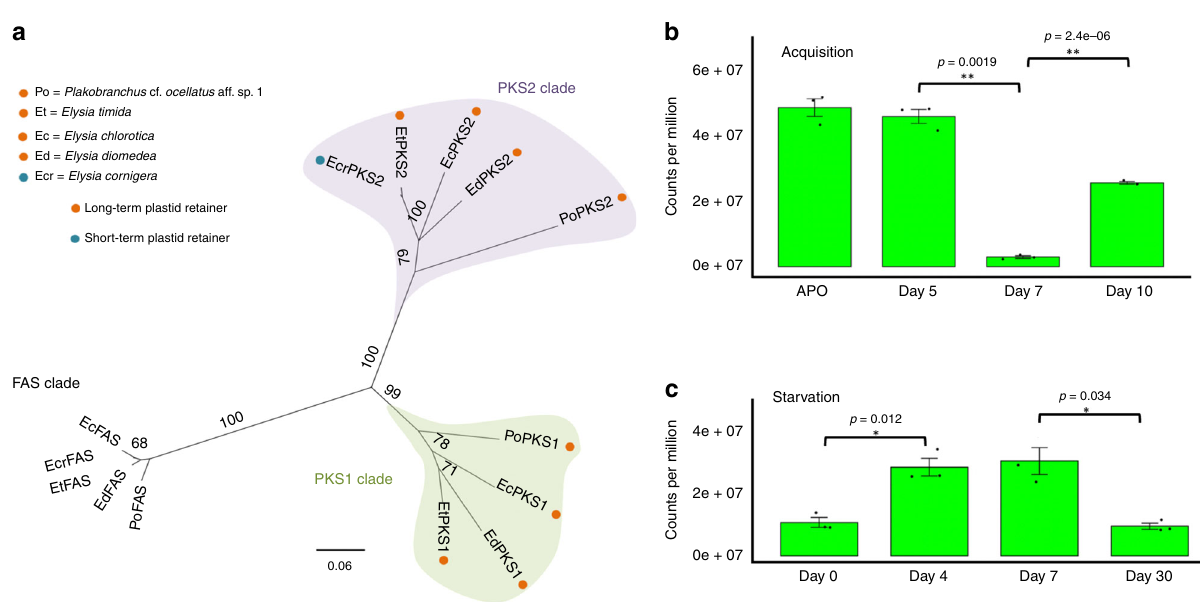
Fig. 5 EcPKS1 and relatives are associated with photosynthetic sacoglossans. a . EcPKS1 is speci fi c to LTR sacoglossans. A neighbor-joining tree based on the acyltransfersase domain of sacoglossan PKS and FAS proteins made using UPGMA. Numbers indicate consensus support (%). The PKS1 clade contains all LTR organisms (orange dots), while FAS and PKS2 includes the non-LTR E. cornigera . b Expression of EcPKS1 during development and c during starvation. APO indicates the aposymbiotic state, at the transition to the benthic state when chloroplasts are acquired. The expression data thus show that EcPKS1 production is highest as chloroplasts are being acquired, and during starvation its expression increases as photosynthesis becomes more important to animal survival. Each time point has a sample size of n = 3 and expressed as mean ± standard error. P values ( p < 0.000****; p < 0.001***; p < 0.1**; p < 0.05*) between time points were done using T test